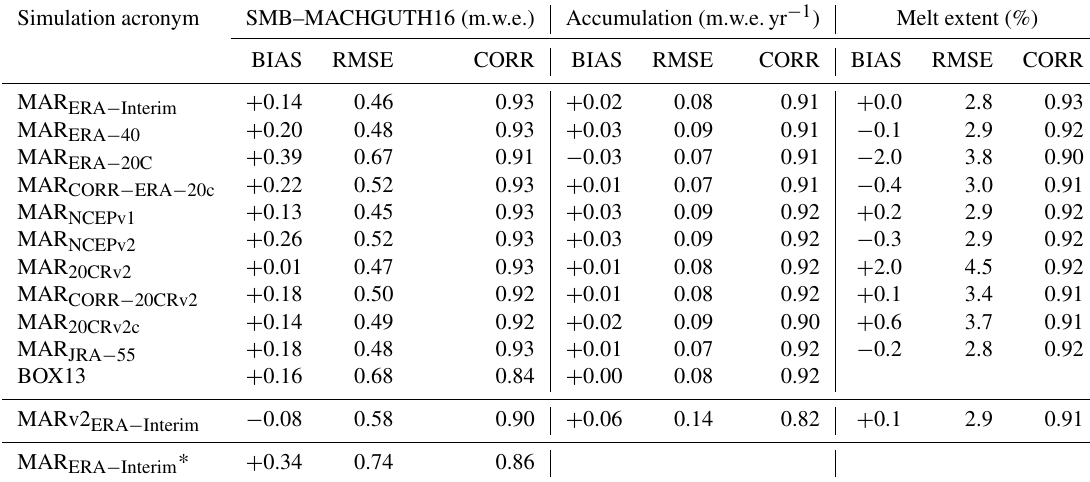
Table 3. Comparison with SMB from the MACHGUTH16 database over 1958–2010, ice-core-based accumulation from Bales et al. (2001, 2009) and Ohmura et al. (1999), and satellite-derived melt extent over 1979–2010. MAR ERA − Interim (MAR ERA − 40 ) means that MAR was forced by ERA-40 over 1958–1978 (1958–2000) and ERA-Interim over 1979–2015 (2001–2015). Finally, MAR ERA − Interim ∗ means that the extrapolation of Franco et al. (2012) was not used to correct the MAR SMB with respect to the elevation differences between MAR and the MACHGUTH16 measurement